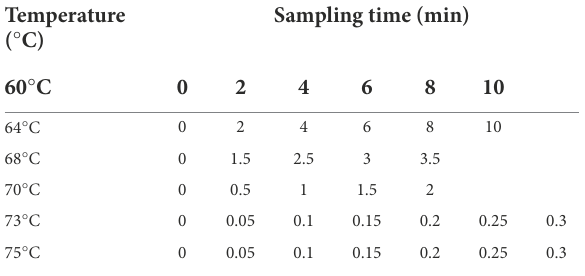
TABLE 1 Temperature applied during the isothermal experiment and the respective sampling time.